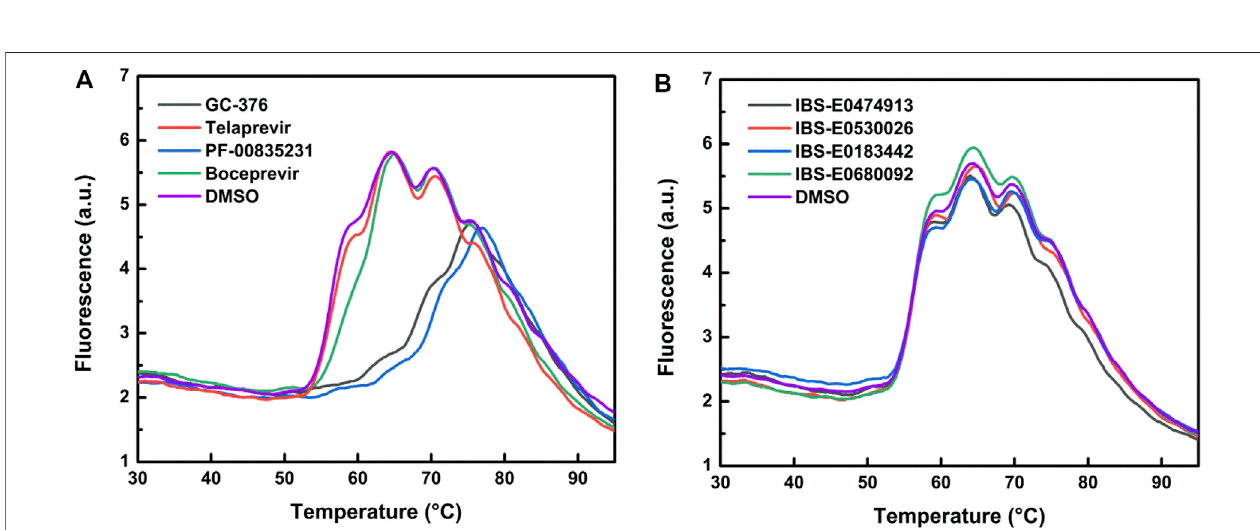
FIGURE 8 | Melting curves of WT M pro in the absence and presence of covalent (A) or noncovalent (B) inhibitors.